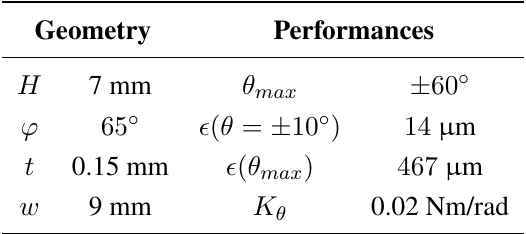
Table 1. Final values of the X 2